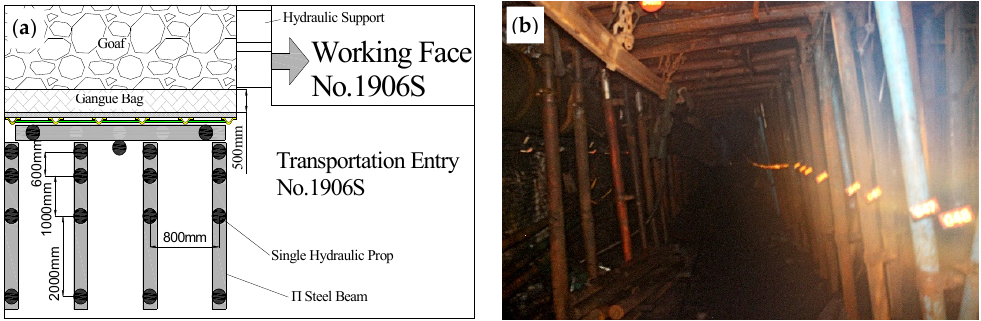
Figure 15. Design and construction of temporary support: ( a ) design; ( b ) construction.